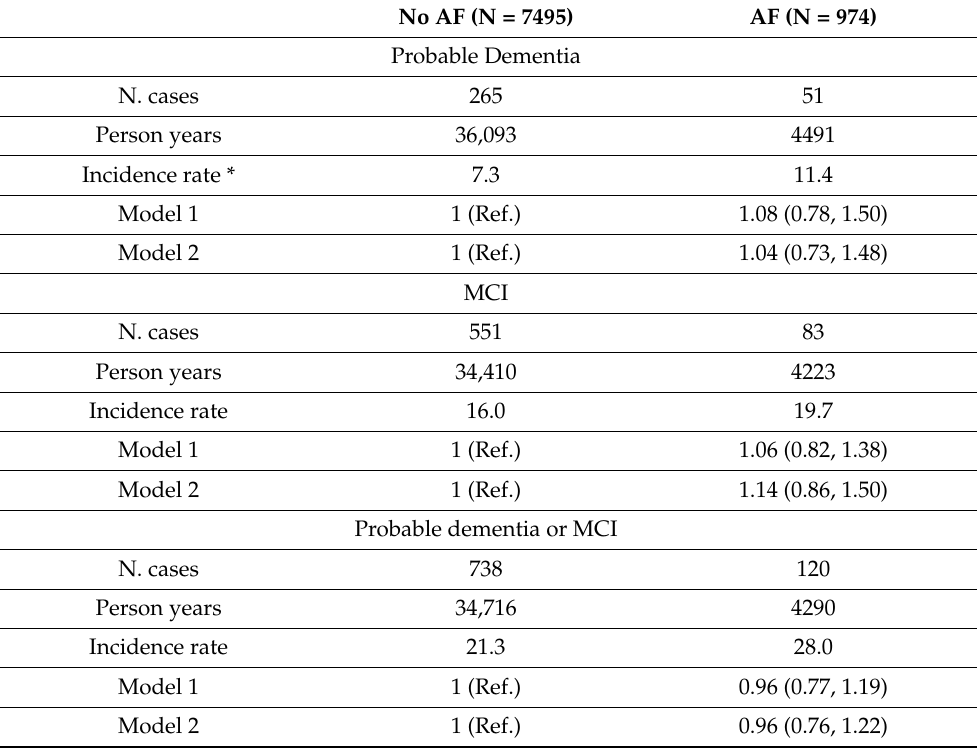
Table 3. Hazard ratios and 95% confidence intervals for association of time-dependent AF (any diagnosis source) with probable dementia and MCI, SPRINT.